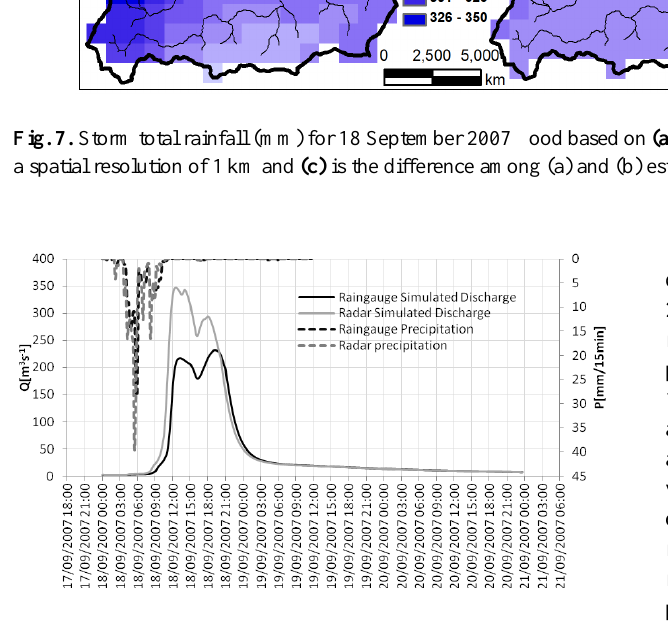
Fig. 8. Calibrated radar and raingauge interpolated precipitation simulated hydrographs for Zelezniki subbasin for the flash flood event on 18 September 2007.